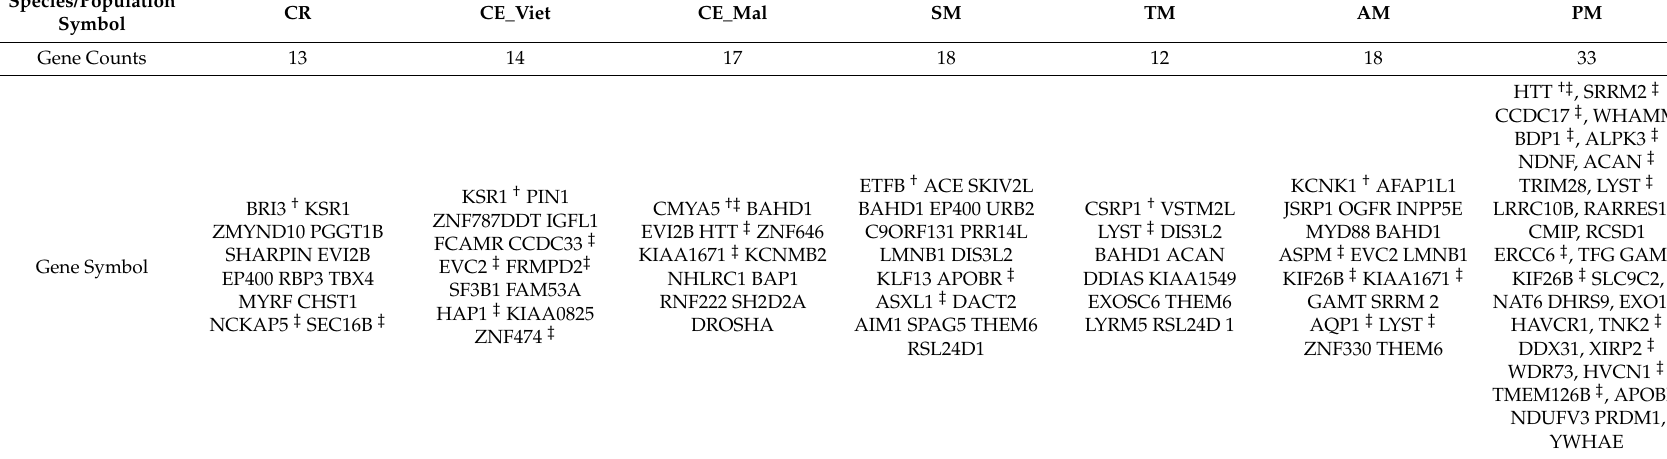
Table 5. Positively selected genes (PSGs) identified by PAML for different Macaca species/population. CE_Viet represents Vietnamese cynomolgus macaque (CE1 in Table 1), and CE_Mal stands for Malaysian cynomolgus macaque (CE2 in Table 1). Species/Population